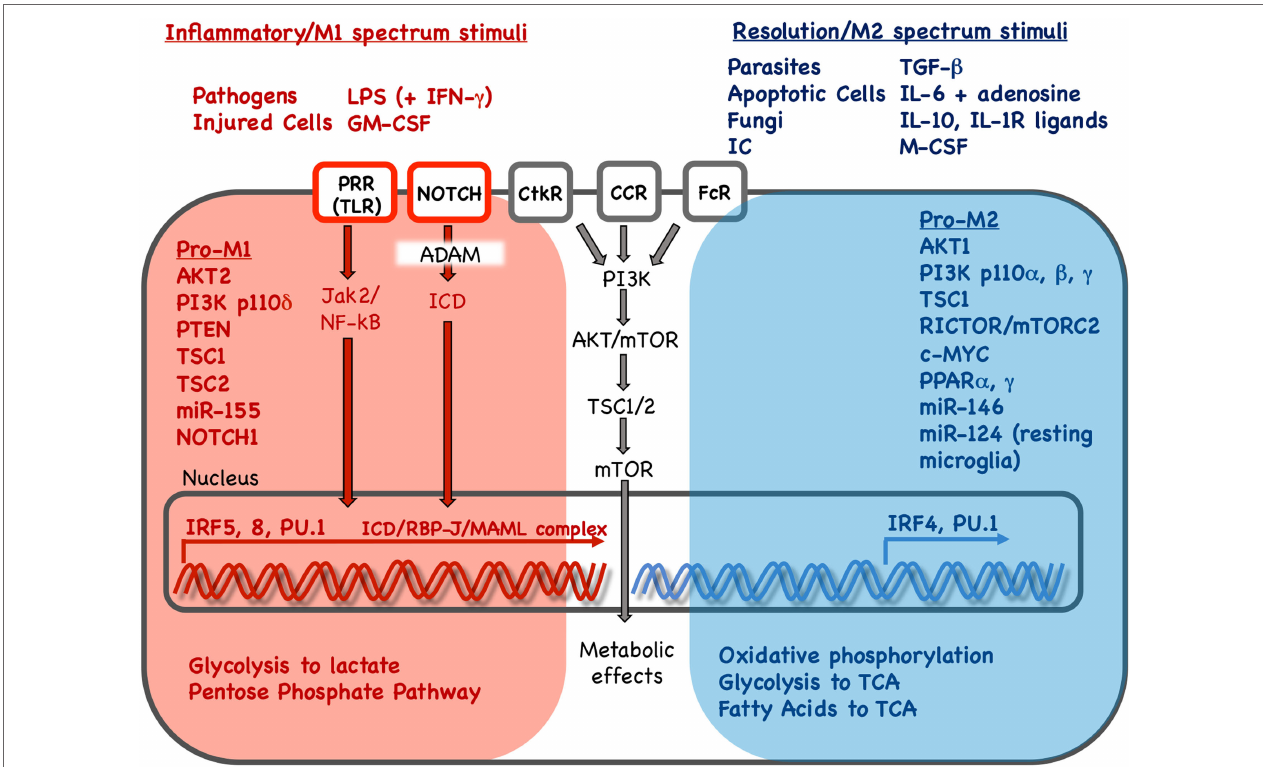
FiGURe 1 | Key stimuli and molecular pathways in inflammatory vs. resolution phenotype in mononuclear phagocytes. Inflammatory and resolution macrophage phenotype results as external stimuli are integrated via signaling pathways to drive phenotype-supporting transcriptional programs and cellular metabolism. Red and blue color indicates pathways, stimuli, transcription factors and metabolic processes associated with inflammatory or resolution phenotype, respectively. Inflammatory phenotype is induced or promoted by pathogens, injured cells and in vitro stimuli. In contrast, resolution spectrum phenotypes are induced or promoted by parasites, fungi, apoptotic cells, immune complexes and other cytokine/growth factor stimuli. Pathogen or injury signals sensed via pathogen- recognition receptors (PRR) such as Toll-like receptors (TLR) result in Janus activated kinase (Jak)2 and nuclear factor kappa B (NF- κ B) activation. Signals received via Notch receptors, cytokine receptor (CtkR), chemokine receptor (CCR), and Fc receptor (FcR) stimulation are also integrated, defining gene expression and downstream metabolic reprogramming. Interferon regulatory factors (IRFs) 5 and 8 promote inflammatory gene expression while IRF 4 promotes resolution phenotype genes. Gene expression promotes changes in nutrient uptake and metabolic pathways that support inflammatory or resolution macrophage phenotype. LPS, lipopolysaccharide; IFN- γ : interferon- γ ; GM-CSF, granulocyte monocyte colony stimulation factor; IC, immune complexes; TGF- β , transforming growth factor- β ; IL, interleukin; IL-1R, interleukin 1 receptor; M-CSF, monocyte colony stimulation factor; PI3K, phosphoinositide 3 kinase; AKT, serine threonine kinase; mTOR, mammalian target of rapamycin; PTEN, phosphatase and tensin homolog; TSC, tuberous sclerosis complex; c-MYC, PPAR, peroxisome proliferator activated receptor; ADAM, A disintegrin and metalloproteinase; RBP-J, recombination signal binding protein for immunoglobulin kappa J region; MAML, mastermind-like; Rictor, rapamycin-insensitive companion of mTOR; TCA, tricarboxylic acid/Krebs